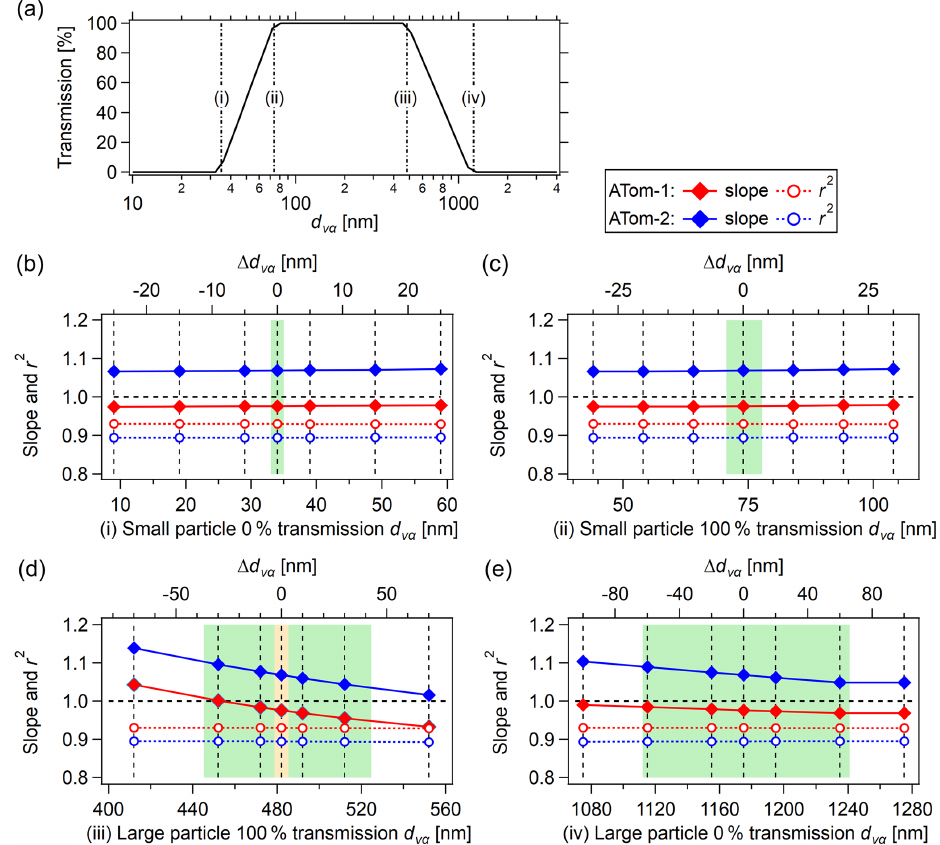
Figure 6. Sensitivity test of AMS transmission: the regression slopes and correlations between V chem ( y axis) and V phys , AMS ( x axis) by artificially changing the AMS transmission (a) . The four subpanels labeled with (b, c, d, e) are for the four anchoring points, (i) 35nm, (ii) 100nm, (iii) 482nm, and (iv) 1175nm (all in d va ), as shown in the top AMS transmission figure. In (d, e) , the green-tinted background indicates the 1 standard deviation range from in-field calibrations, and the orange-tinted background in (d) is the narrower standard deviation range estimated from multiple calibrations (Fig.